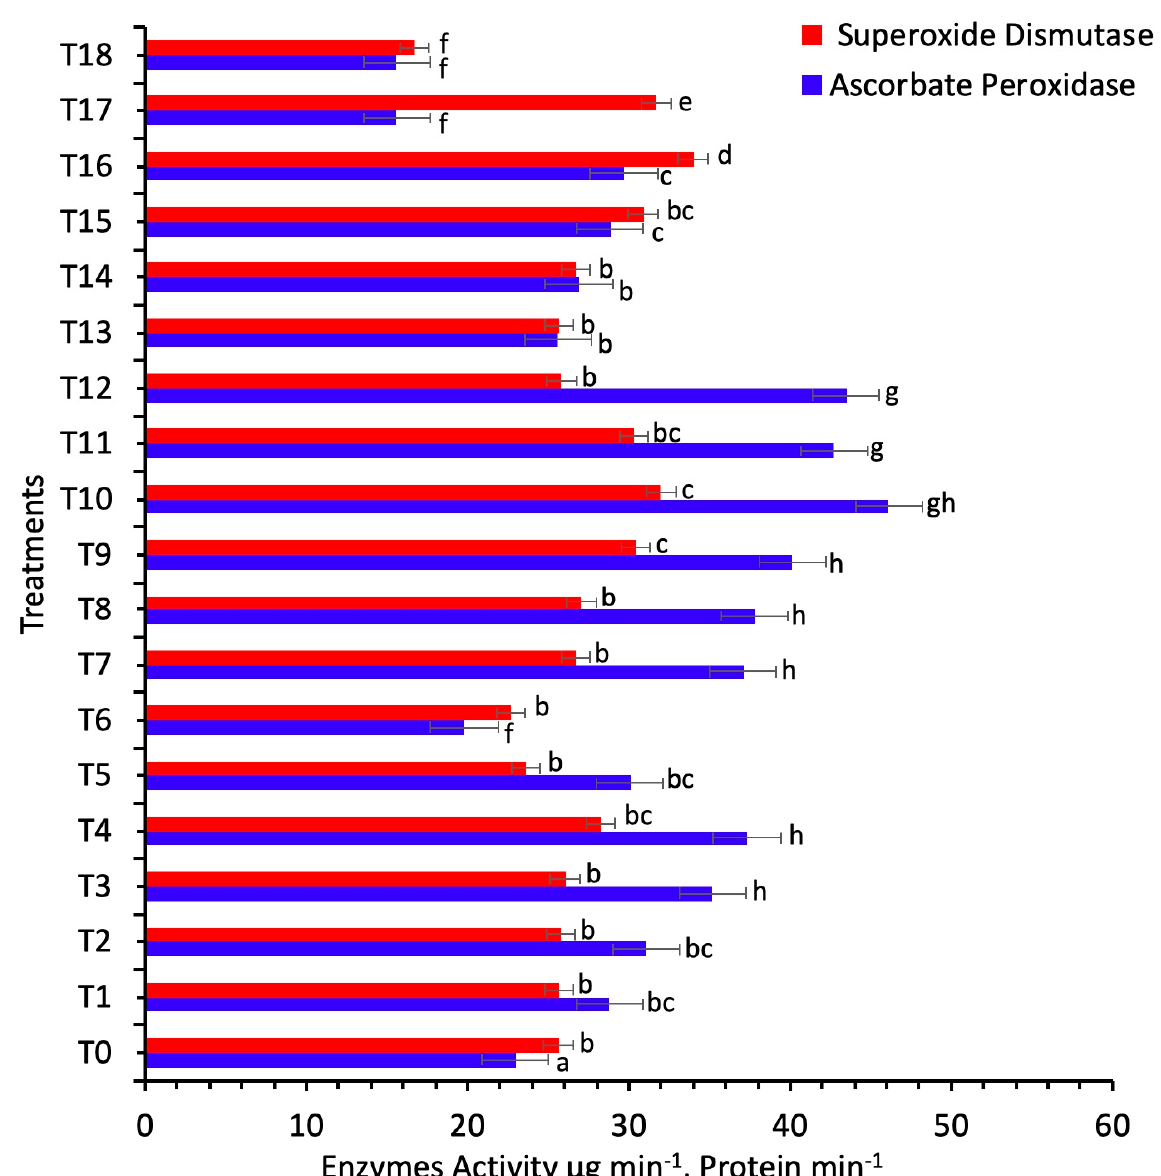
Figure 4. Effects of different treatments of AgNPs on superoxide dismutase and ascorbate peroxidase contents of sunflower. Lowercase letters differed significantly at 5% probability levels, using Duncan’s Multiple Range Test ( p < 0.05).